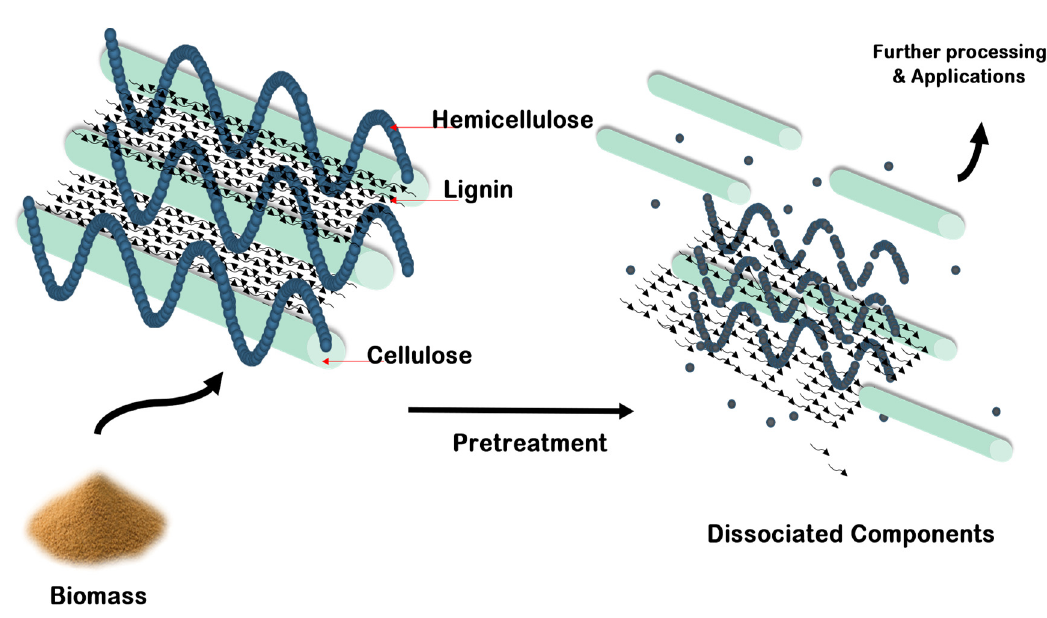
Figure 1. Effect of pretreatment on